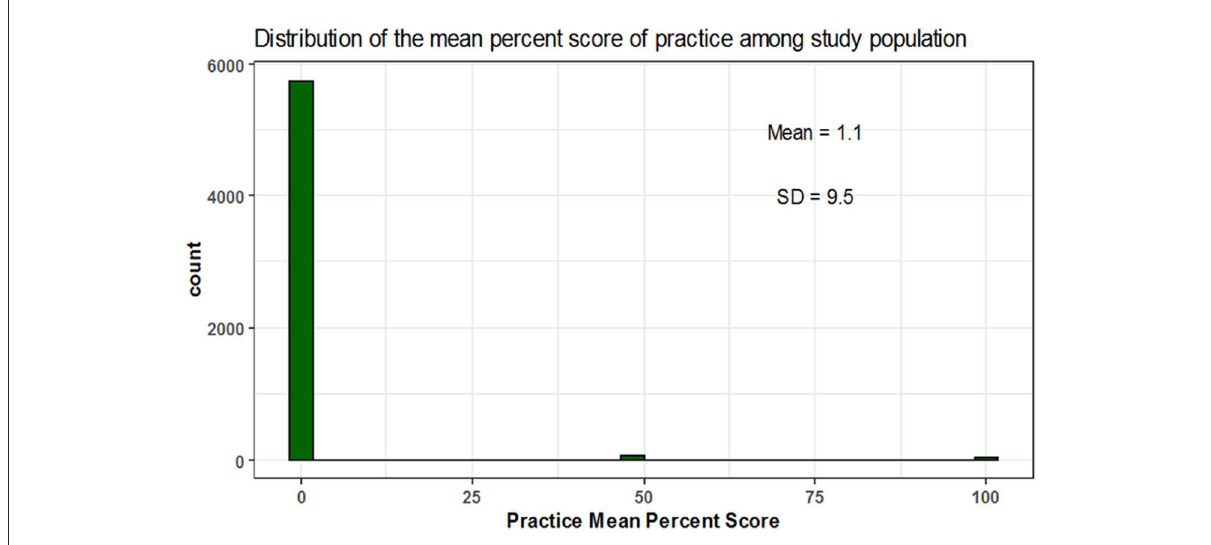
FIGURE5 Mean percent score distribution for practice.